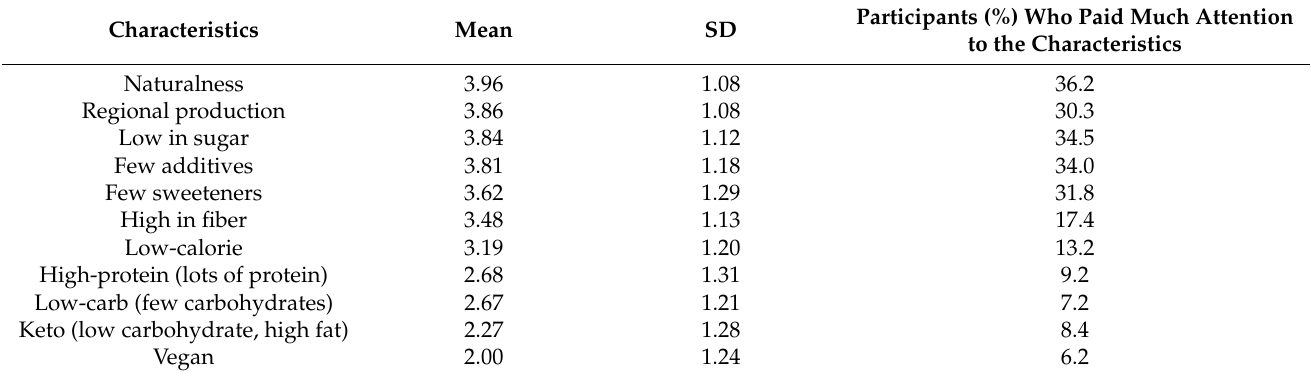
Table A1. Importance of characteristics in one’s own